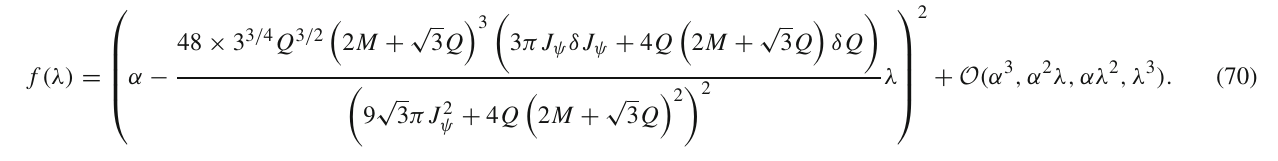
and α = 0 . 01 with λ = 0 . 1. That leads to a) f (λ) = 6 . 3832 × 10 − 6 > 0 and b) f (λ) = 50 . 1196 × 10 − 6 >